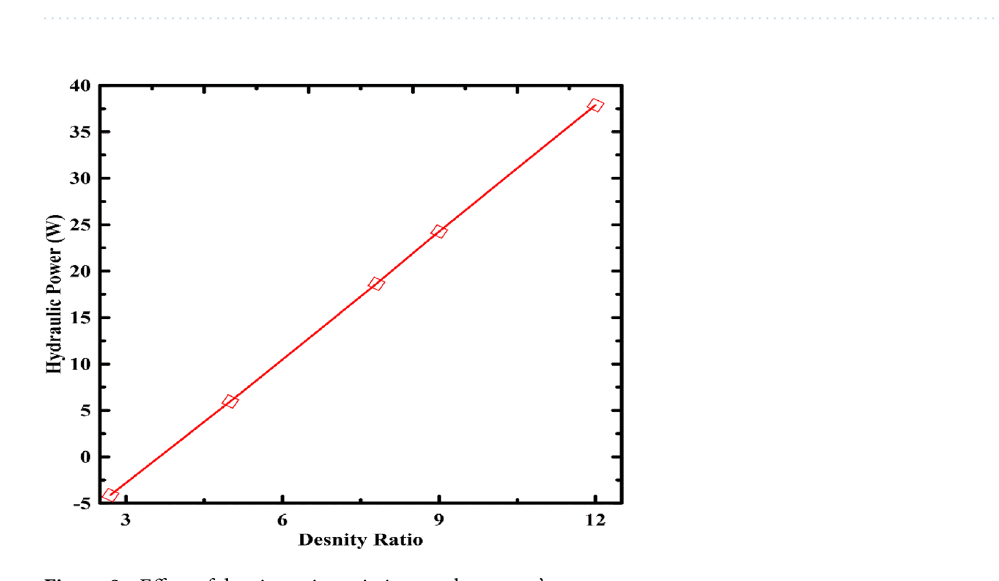
Figure 7. Effect of charge/discharge time variation on the power.